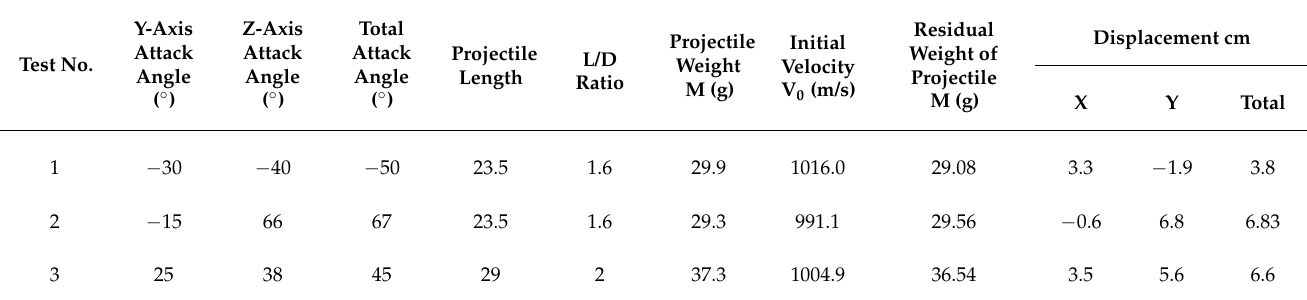
Table 1. Test conditions and results.